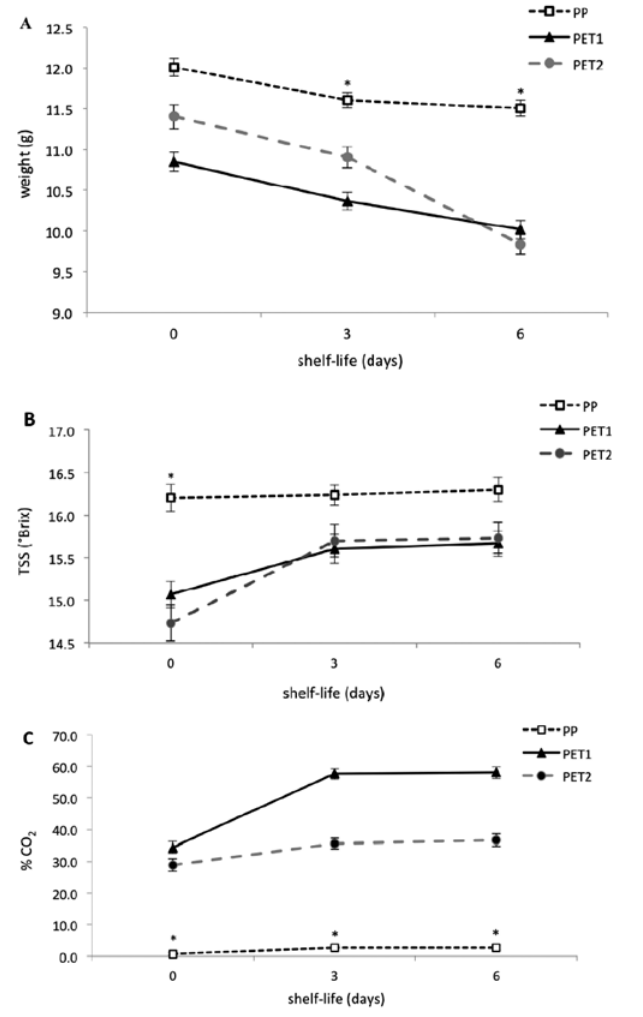
Fig. 1 - Changes in weight loss (A), soluble solid content (B) and headspace CO concentration (C) of minimally processed ‘Red 2 Globe’ grape berries during shelf life after 14 days of cold storage (5°C): microperforated polypropylene packaging in air (PP); non-microperforated polyethylene packaging in 20% CO +air (PET1); non-microperforated polyethylene packaging 2 in 5% O +15% CO +N (PET2). Data are mean±SE. * indicate 2 2 significant differences for values